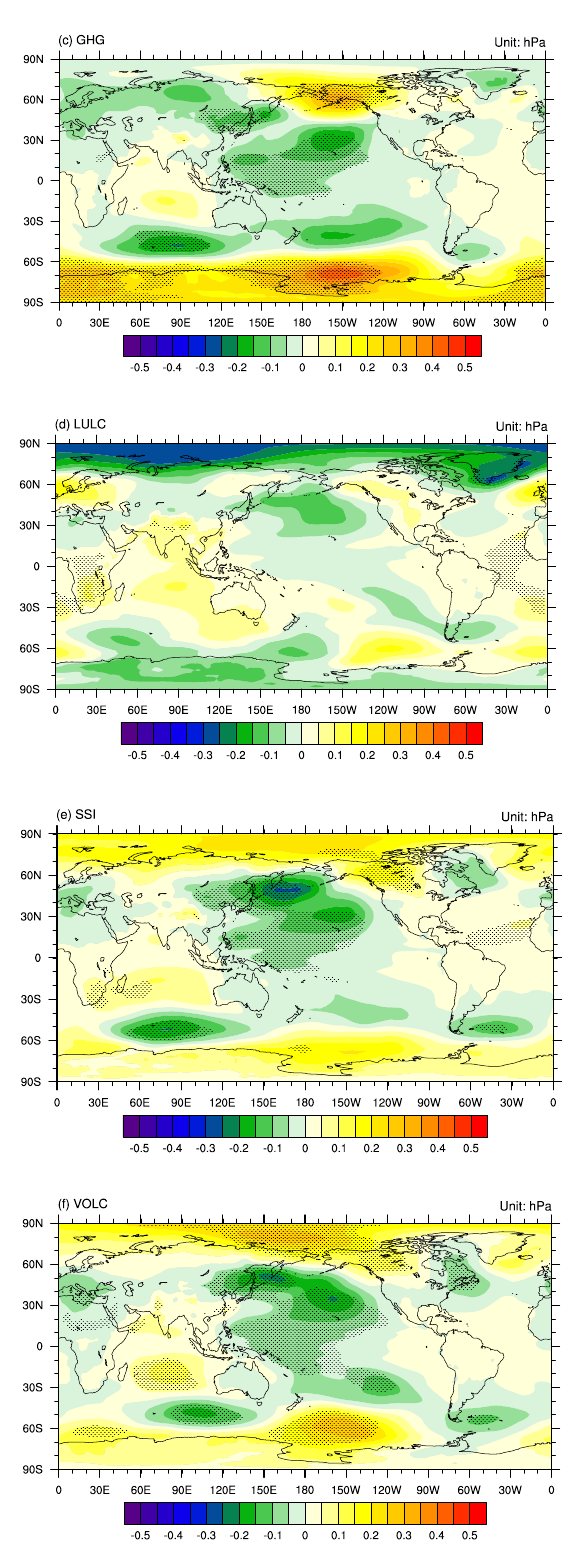
Figure 5. Simulated ensemble-averaged annual sea level pressure anomalies (unit: hPa) during the megadrought years from the long-term means of the control (CTRL) run ( a ), all-forcing (ALL) runs ( b ), greenhouse gas (GHG) runs ( c ), land use and land cover (LULC) runs ( d ), spectral solar irradiance (SSI) runs ( e ), and volcanic eruption (VOLC) runs ( f ). Stippling indicates differences significant at the p = 0.05 level based on a t